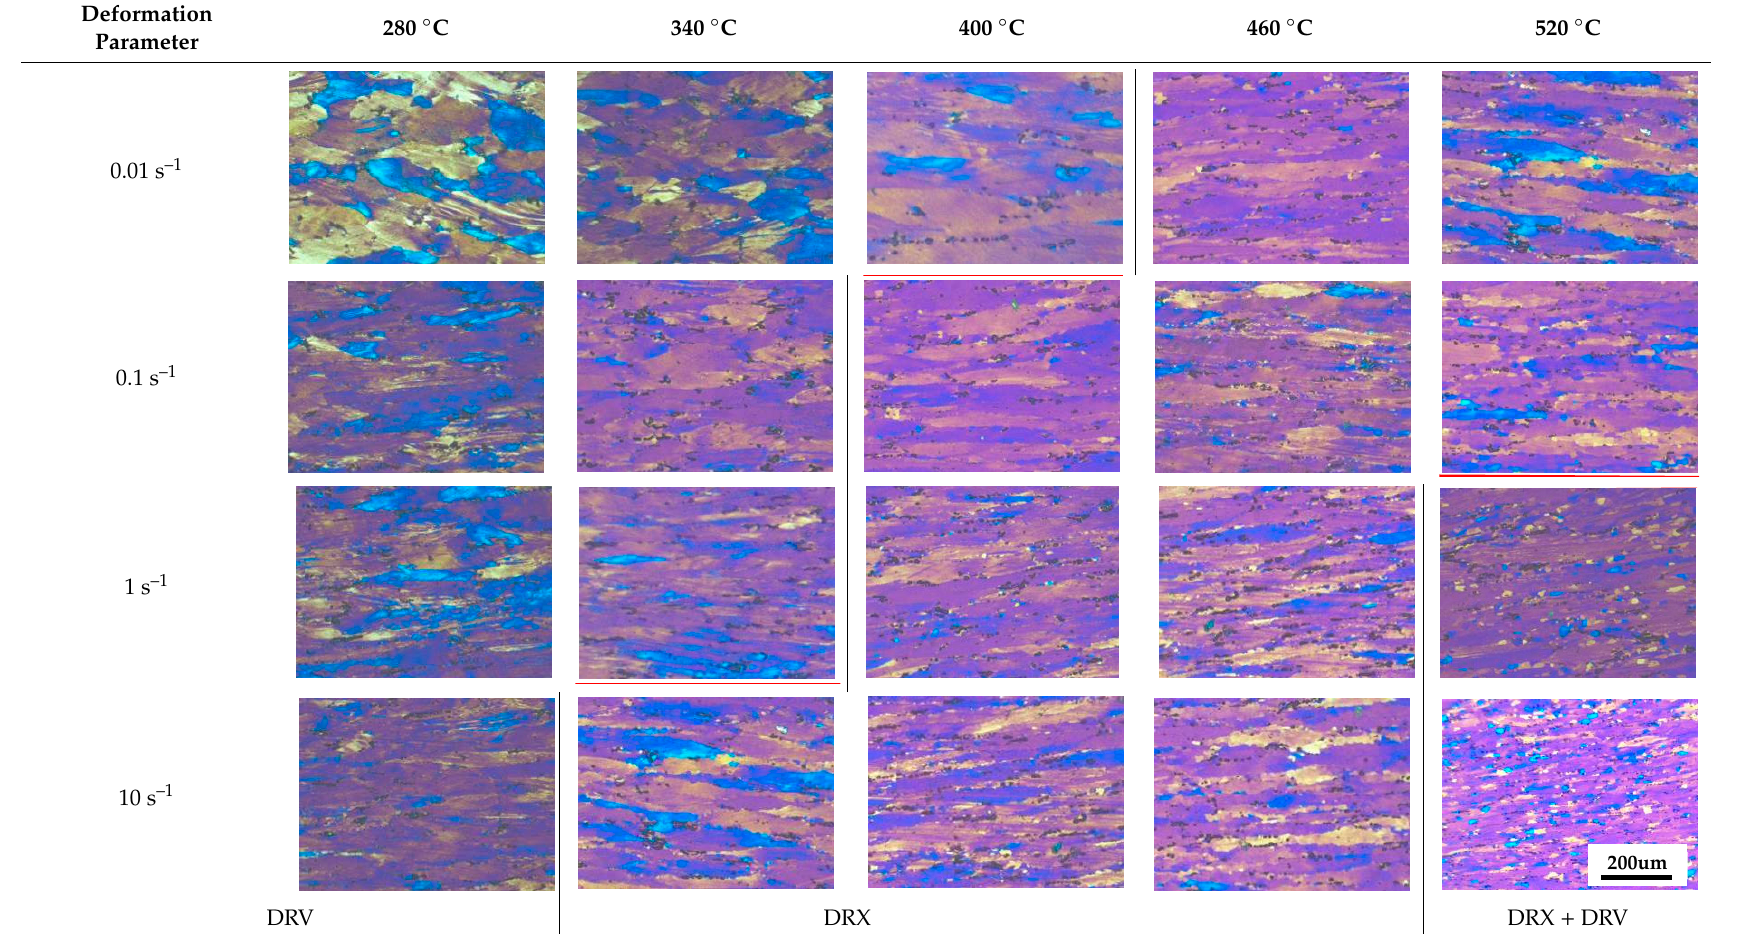
Table 1. Optical microstructure of the Al–4.8Mg alloy under various deformation conditions.